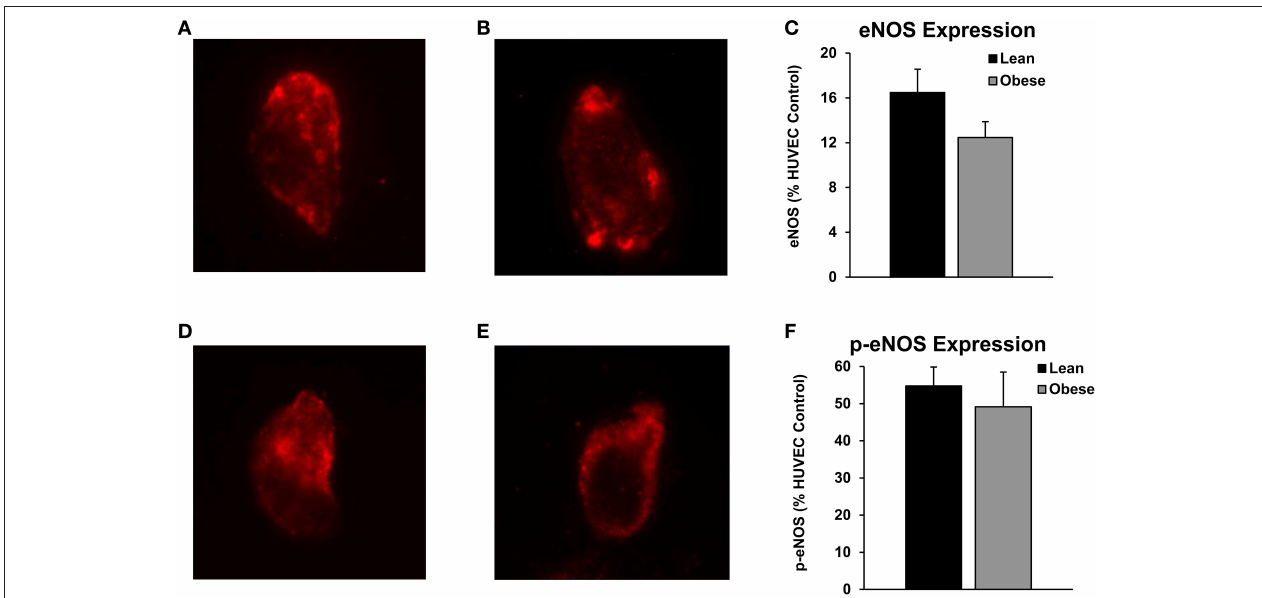
FIGURE 6 | eNOS and p-eNOS expression. Endothelial NOS (eNOS) and phosphorylated eNOS (p-eNOS) protein expression from arterial cell biopsies. Representative images of arterial eNOS staining from a lean (A) and obese (B) subject. eNOS protein expression was similar between a subset of lean ( n = 14 ) and obese ( n = 7 ) adults (C) . Representative images of arterial p-eNOS staining from a lean (D) and obese (E) subject. p-eNOS protein expression was similar between a subset of lean ( n = 16 ) and obese ( n = 5 ) adults (F)